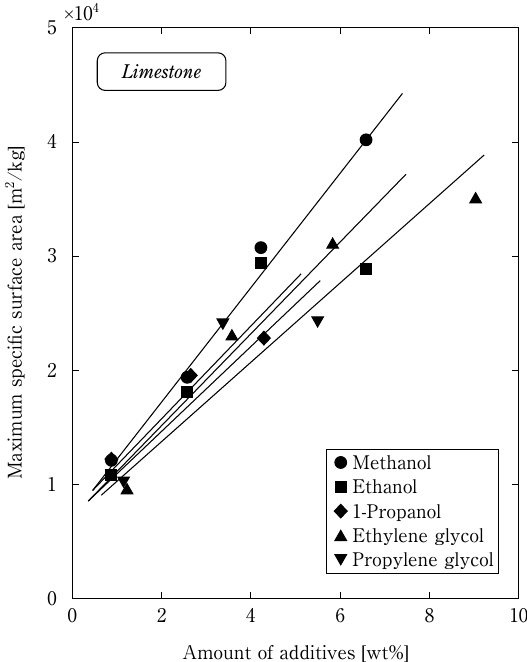
Fig. 4 Variations of specific surface area of limestone as a function of grinding time with the addition amount of ethylene